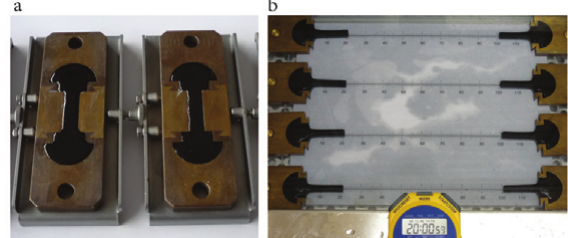
Fig. 1. The selected details of the procedure for stretching test with force data collecting and strain recovery determination: a − bitumen samples with constant cross-sectional dimensions